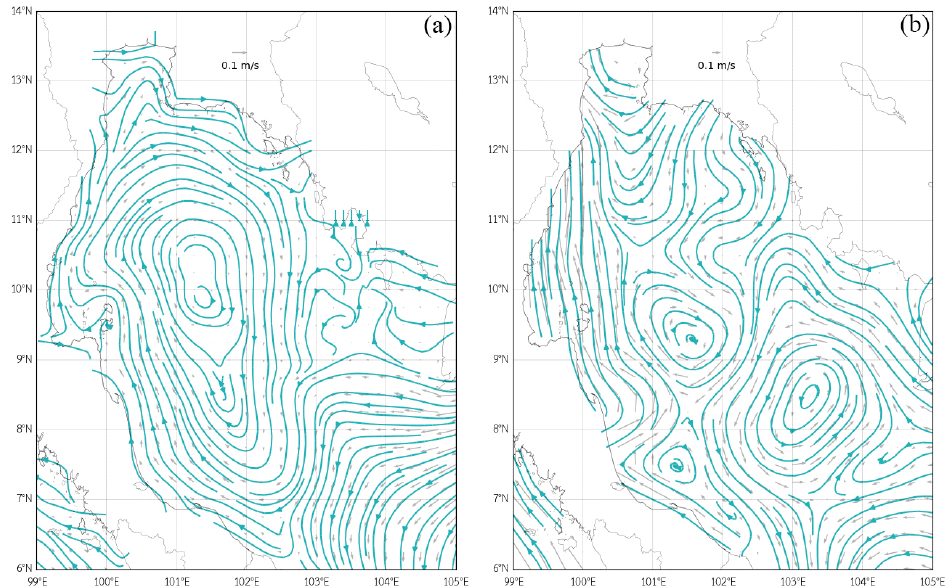
Figure 7. The simulated ( a ) mean surface current velocity from OCM and ( b ) mean surface current from OSCAR in April 2020.